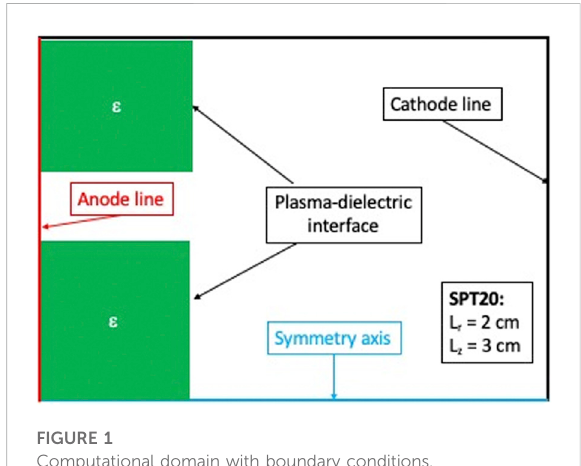
FIGURE 1 Computational domain with boundary